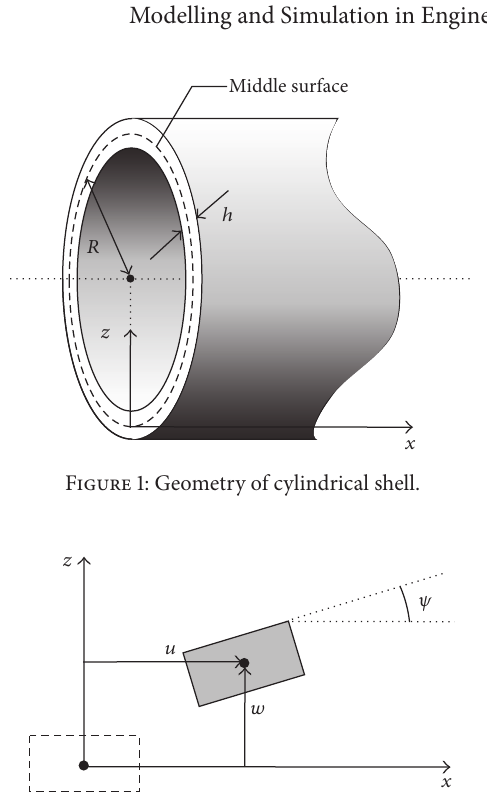
Figure 2: Displacements and rotation of shell